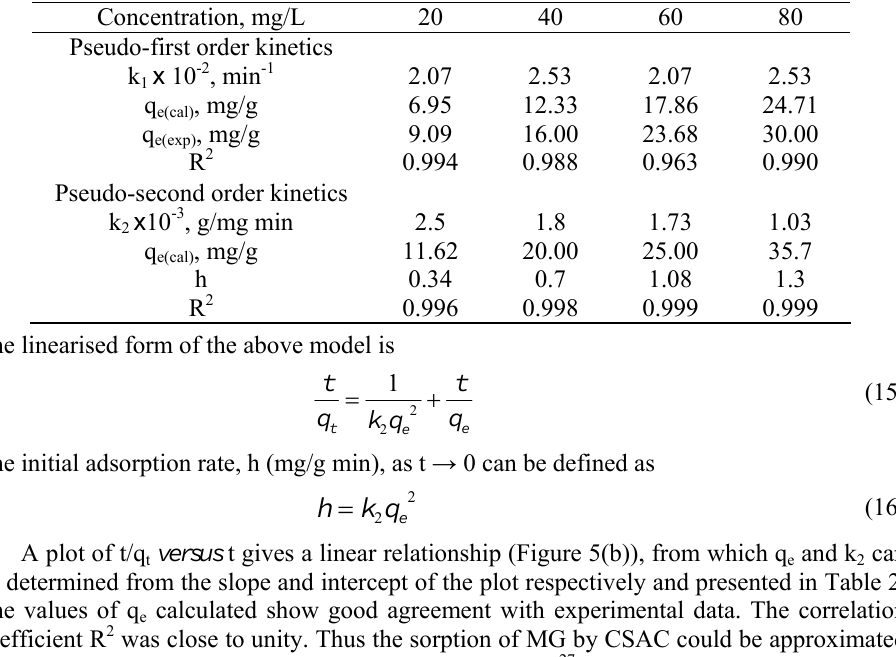
Table 2. Calculated kinetic parameters for the adsorption of MG onto